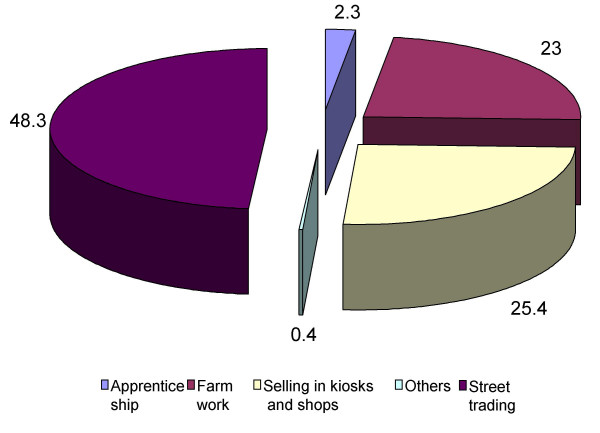
Pattern of child labour among study children.